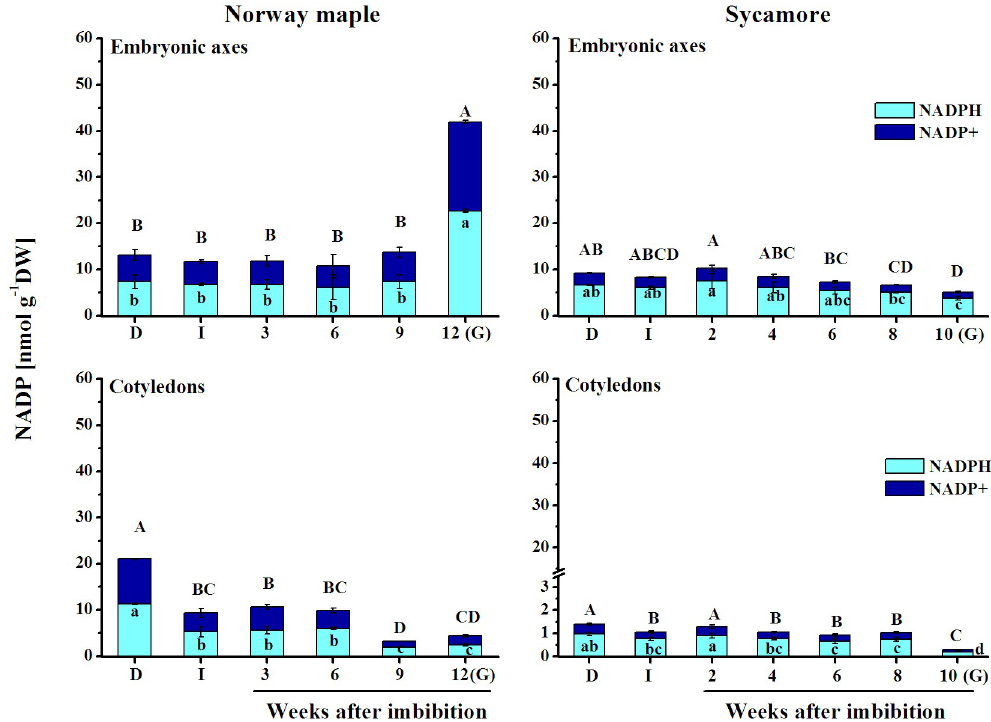
Fig 2. Levels of reduced (NADPH) and oxidized (NADP + ) forms of nicotinamide adenine dinucleotide phosphate (NADP) detected in dry and germinating Norway maple and sycamore seeds. (D) Dry seeds; (I) Imbibed seeds; (G) Germinated seeds. Data represent the mean ± standard deviation of three independent replicates. Statistically significant differences are indicated with different letters (one-way ANOVA followed by Tukey’s test at p � 0.05). The capital letters refer to the oxidized